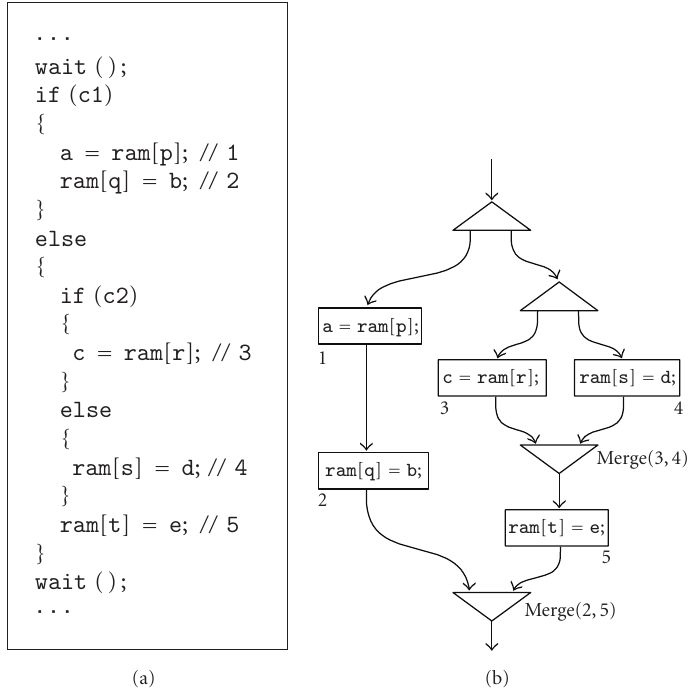
Figure 7: Memory access analysis. (a) SystemC fragment, (b) control flow subgraph corresponding to clock cycle.